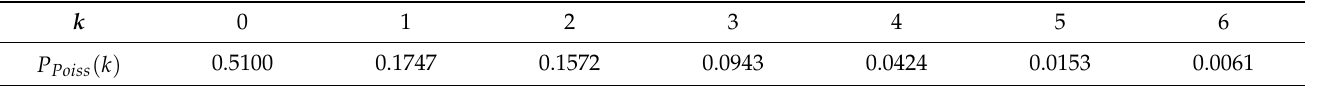
Table 7. The probabilities of k success of the Poisson distribution P Poiss ( k )